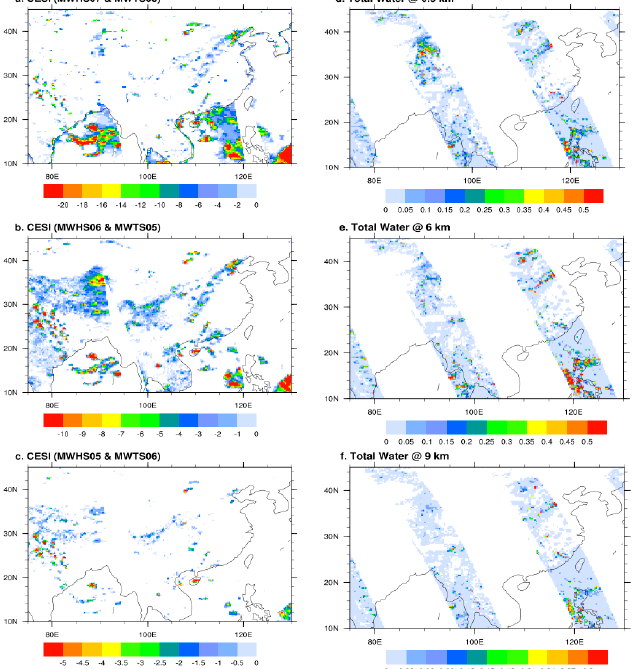
Figure 7. Spatial distributions of CESIs derived from ( a ) CESI low , ( b ) CESI mid and ( c ) CESI high on 17 July 2018. The spatial distributions of GPM total water product are shown at ( d ) 0.5 km, ( e ) 6 km and ( f ) 9 km.